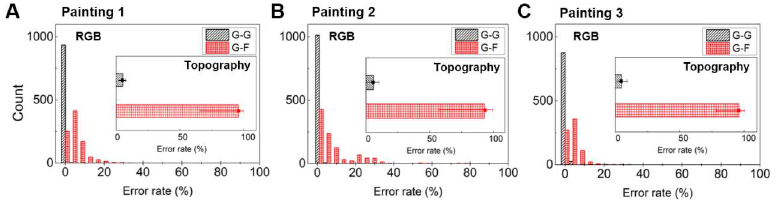
Fig 6. The errorratesof measureddata. T heerror ratesof the RGB spectraandtopographic data(inset); G-G presents the errorrates between the genuineworksand the genuineworks,G-F showsthat betweenthe genuine worksandthe forgeries. The errorratesmeasured on (A) Self-portrait , (B) Morpheme ,and(C) Unknown .